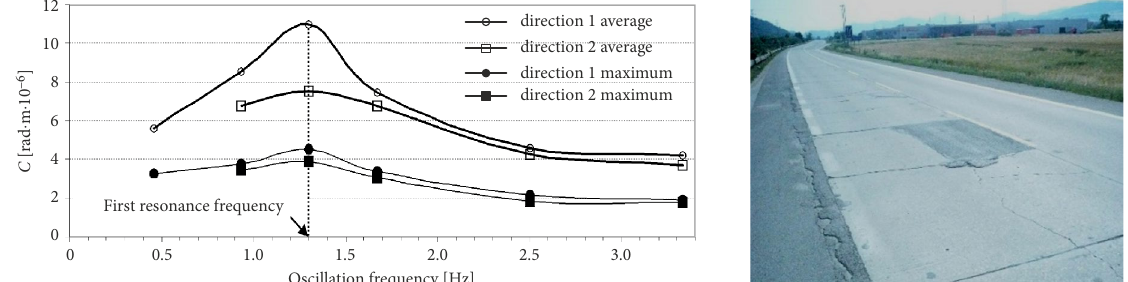
Figure 11. The dependence of parameter C on oscillation frequency for concrete pavement (right side)